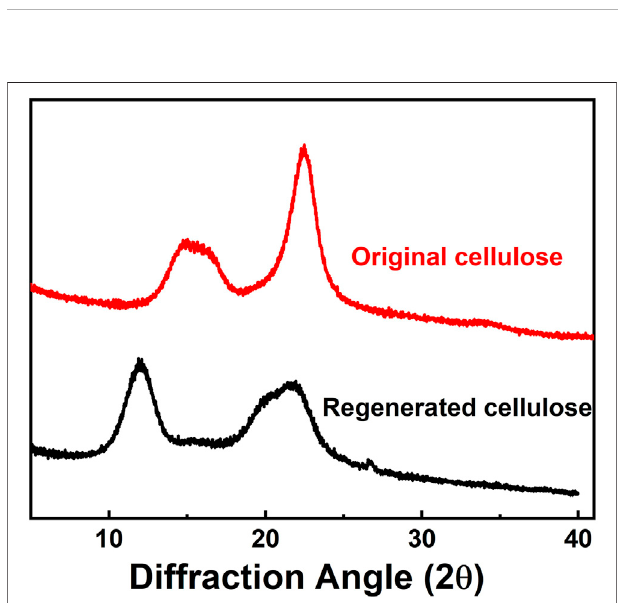
FIGURE 4 | X-ray diffraction pro fi les of original cellulose and the regenerated cellulose.